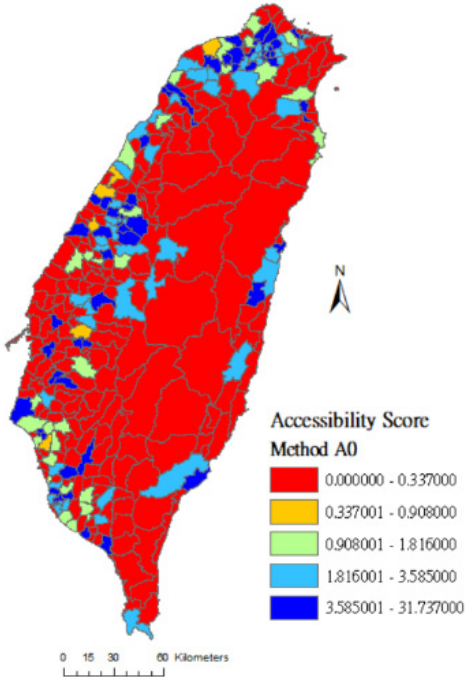
Int. J. Environ. Res. Public Health 2020 , 17 , x FOR PEER REVIEW Figure 1. Accessibility score of rehabilitation physician service in Taiwan using method A0.